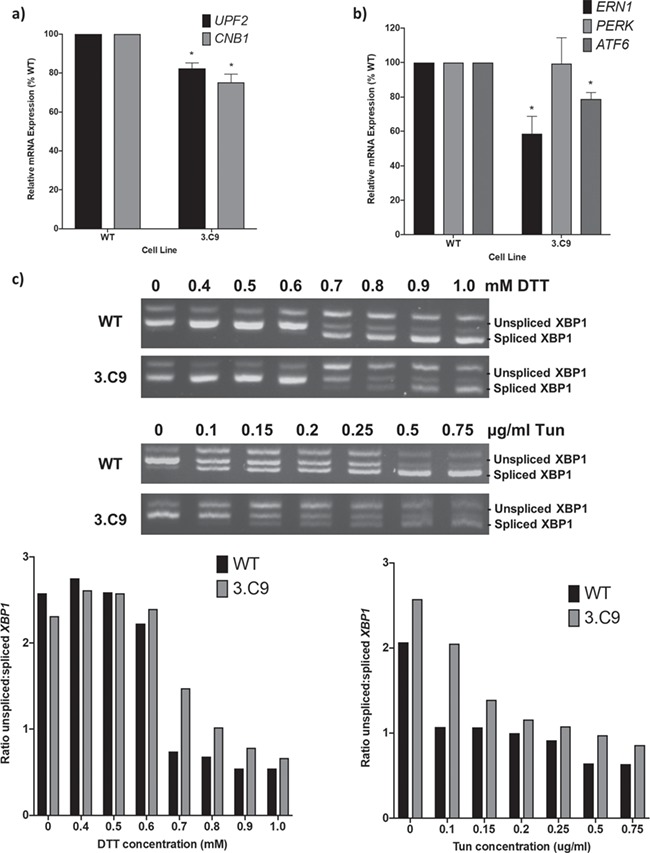
Defects in the endoplasmic reticulum stress response in EFTUD2-mutant cells. (a) Relative mRNA expression levels for the endoplasmic stress (ER) response genes CNB1 and UPF2 in 3.C9 cells compared to WT HEK293 cells, determined using qPCR with cDNA made from the cell lines. Graphs were obtained using the ΔΔCT method with ACTB as the endogenous reference gene. n = 4. *p-value < 0.05. (b) Relative mRNA expression levels for the ER stress response genes ERN1, PERK and ATF6 in 3.C9 cells compared to WT cells, determined using qPCR with cDNA made from the cell lines. Graphs were obtained using the ΔΔCT method with ACTB as the endogenous reference gene. n = 5. *p-value < 0.05. (c) XBP1 splicing in WT and 3.C9 cells following 5 h DTT (above) and Tun (below) treatment at increasing concentrations. cDNA was made from cells lines following 5 h growth at 37°C in 5% CO2 with and without indicated agents and used as a template in RT-PCR reactions with primers that amplify both the spliced and unspliced forms of XBP1. Relative intensities of spliced and unspliced XBP1 were quantified using ImageJ software.